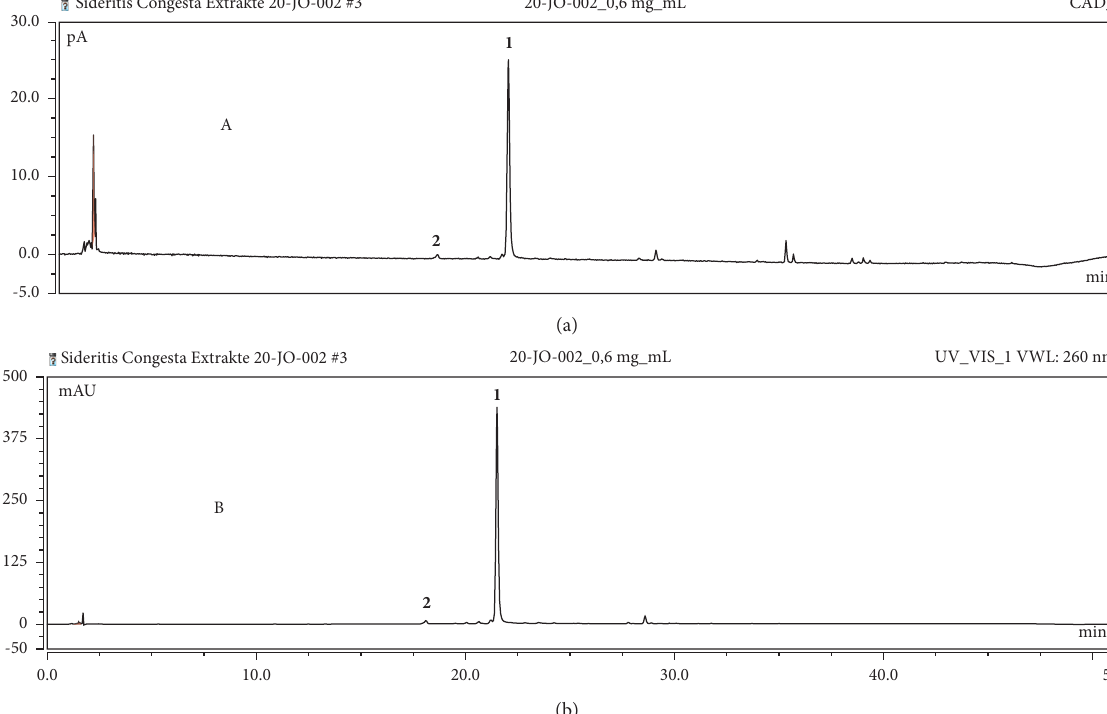
Figure 3: HPLC chromatograms of the aqueous crude extracts obtained from S. congesta with a charged aerosol detector (CAD) (a) and PDA detector at 260nm(b). The peak at 21.6min corresponds to stachyspinoside (1) , and the peak at 18.1 min (2) corresponds to the highest closest peak to stachyspinoside and was considered for the calculation of the separation factor ∝